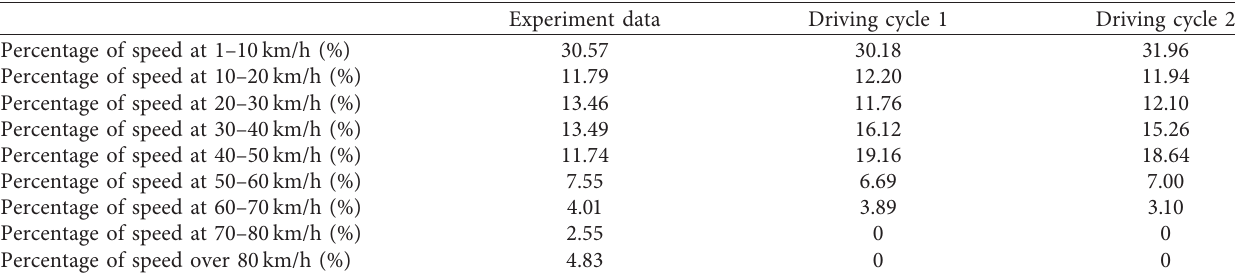
Table 10: Comparison of validity analysis feature parameters.